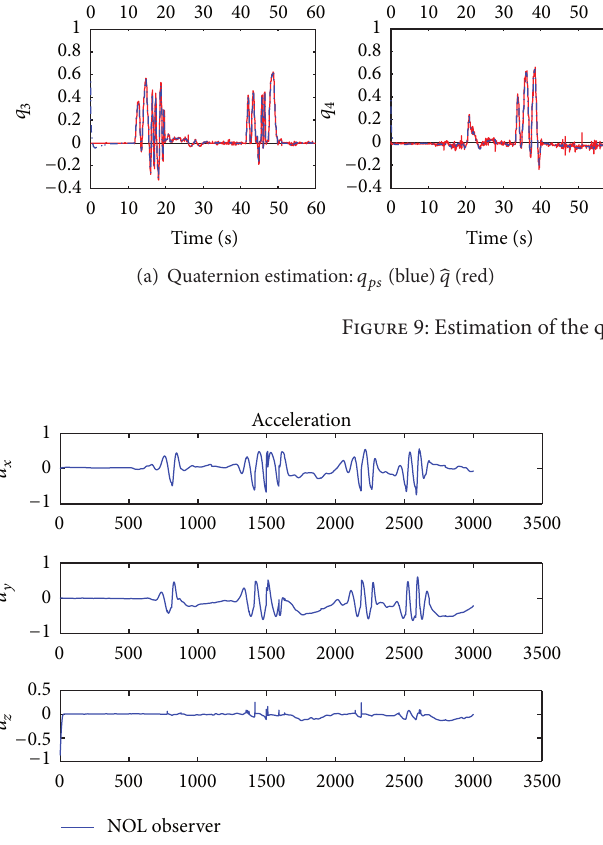
Figure 10: Acceleration of the movement. Figure 11: Anatomical movements of the shoulder: 𝐴 1 = 𝜓 : internal-external rotation, 𝐴 2 = 𝜓 : abduction-adduction, and 𝐴 3 = 𝜃 :